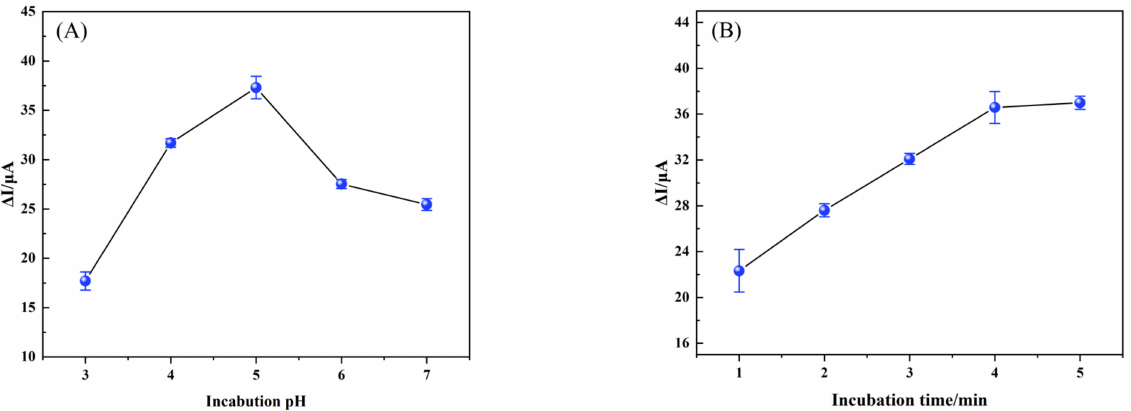
Figure 8. The plots for the relationship of ( A ) Incubation pH (3.0, 4.0, 5.0, 6.0, 7.0) and ( B ) Incubation time (1, 2, 3, 4, 5 min) on the current difference ( ∆ I) by DPV in 5 mmol · L − 1 [Fe (CN) 6 ] 3 − /4 − (1.0 mol · L − 1 KCl). ∆ I = I 0 − I 1 , I 0 and I 1 were the peak currents obtained from MIP/TBC/GCE before and after incubated with 0.1 µ M